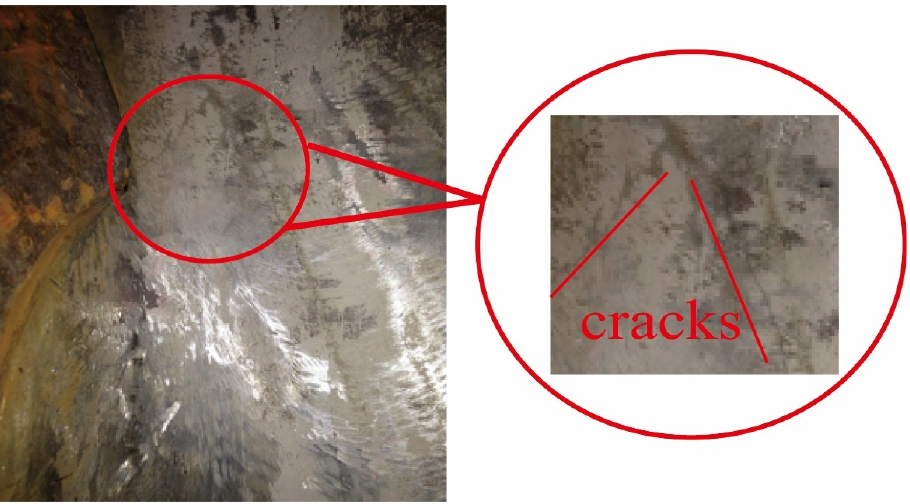
Figure 13. Crack distribution of the old axial-flow pump blade.